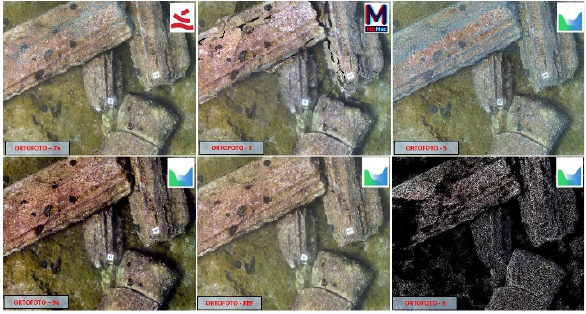
Figure 10. Orthophotos